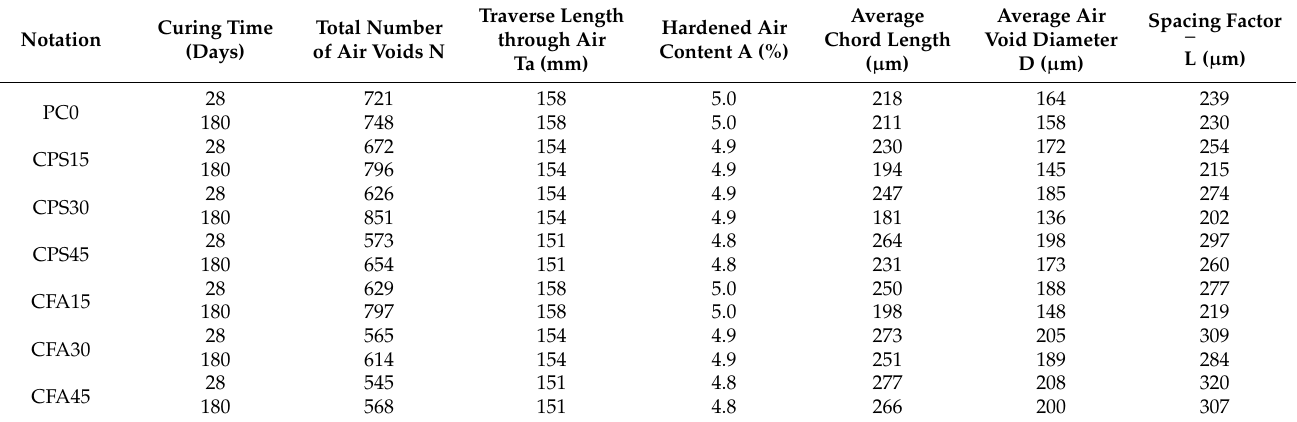
Table 5. Air void structures of hydraulic concretes added with FGPS and fly